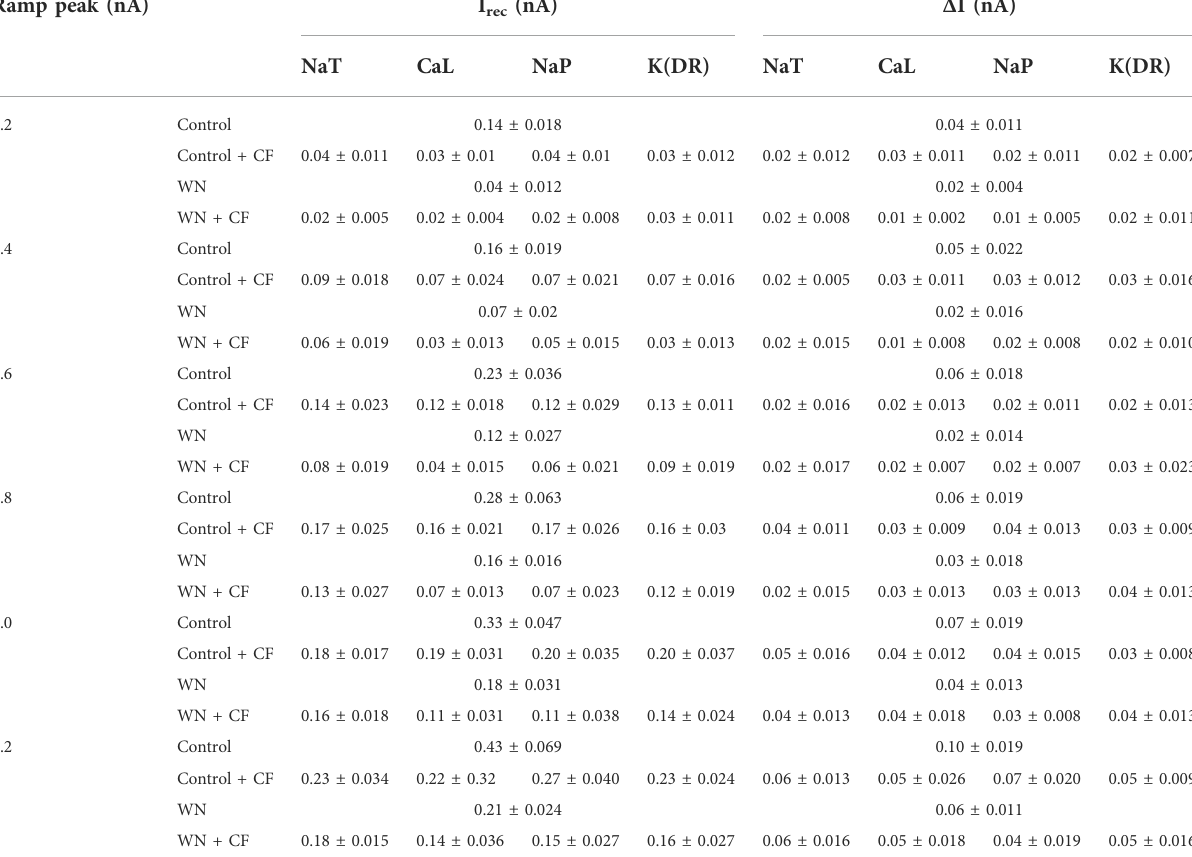
TABLE 5 Effect of channel fl icker on recruitment and decruitment current. Ramp peak